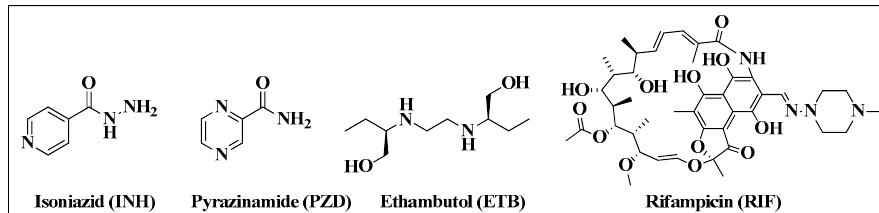
Figure 3. Chemical structures of anti-TB drugs.